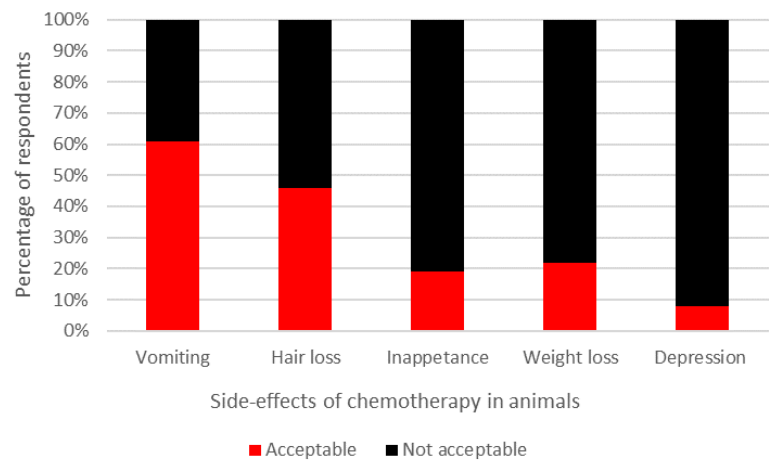
Figure 2. Acceptability of side effects associated with chemotherapy treatment in dogs and cats.